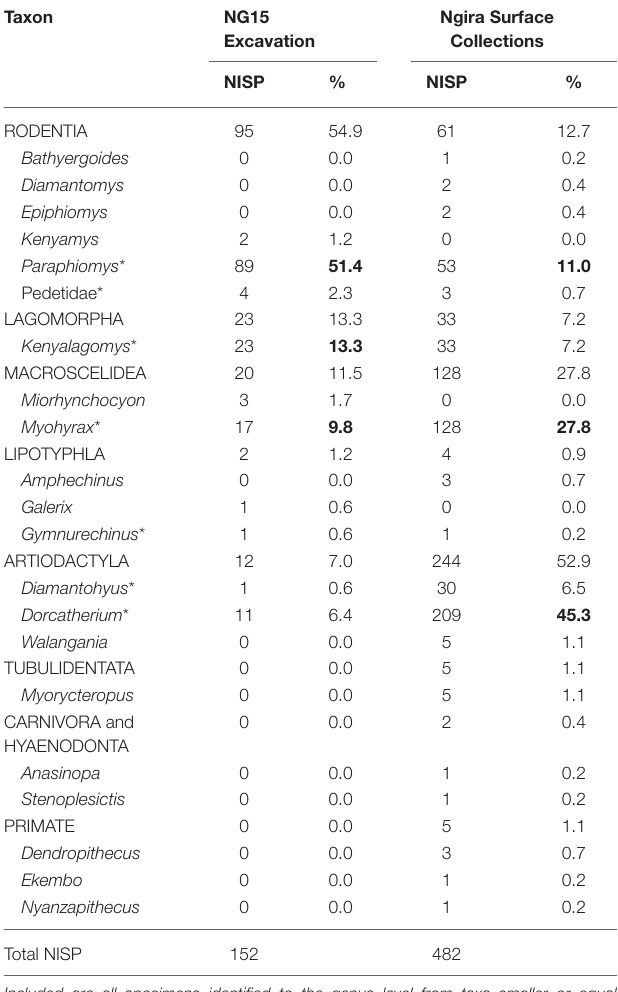
TABLE 3 | Composition of the small mammal fauna from Ngira, recovered from the NG15 excavations and from surface collections (including REACHE surveys in 2010, 2012, 2013, 2015 and historical collections housed at the NMK).